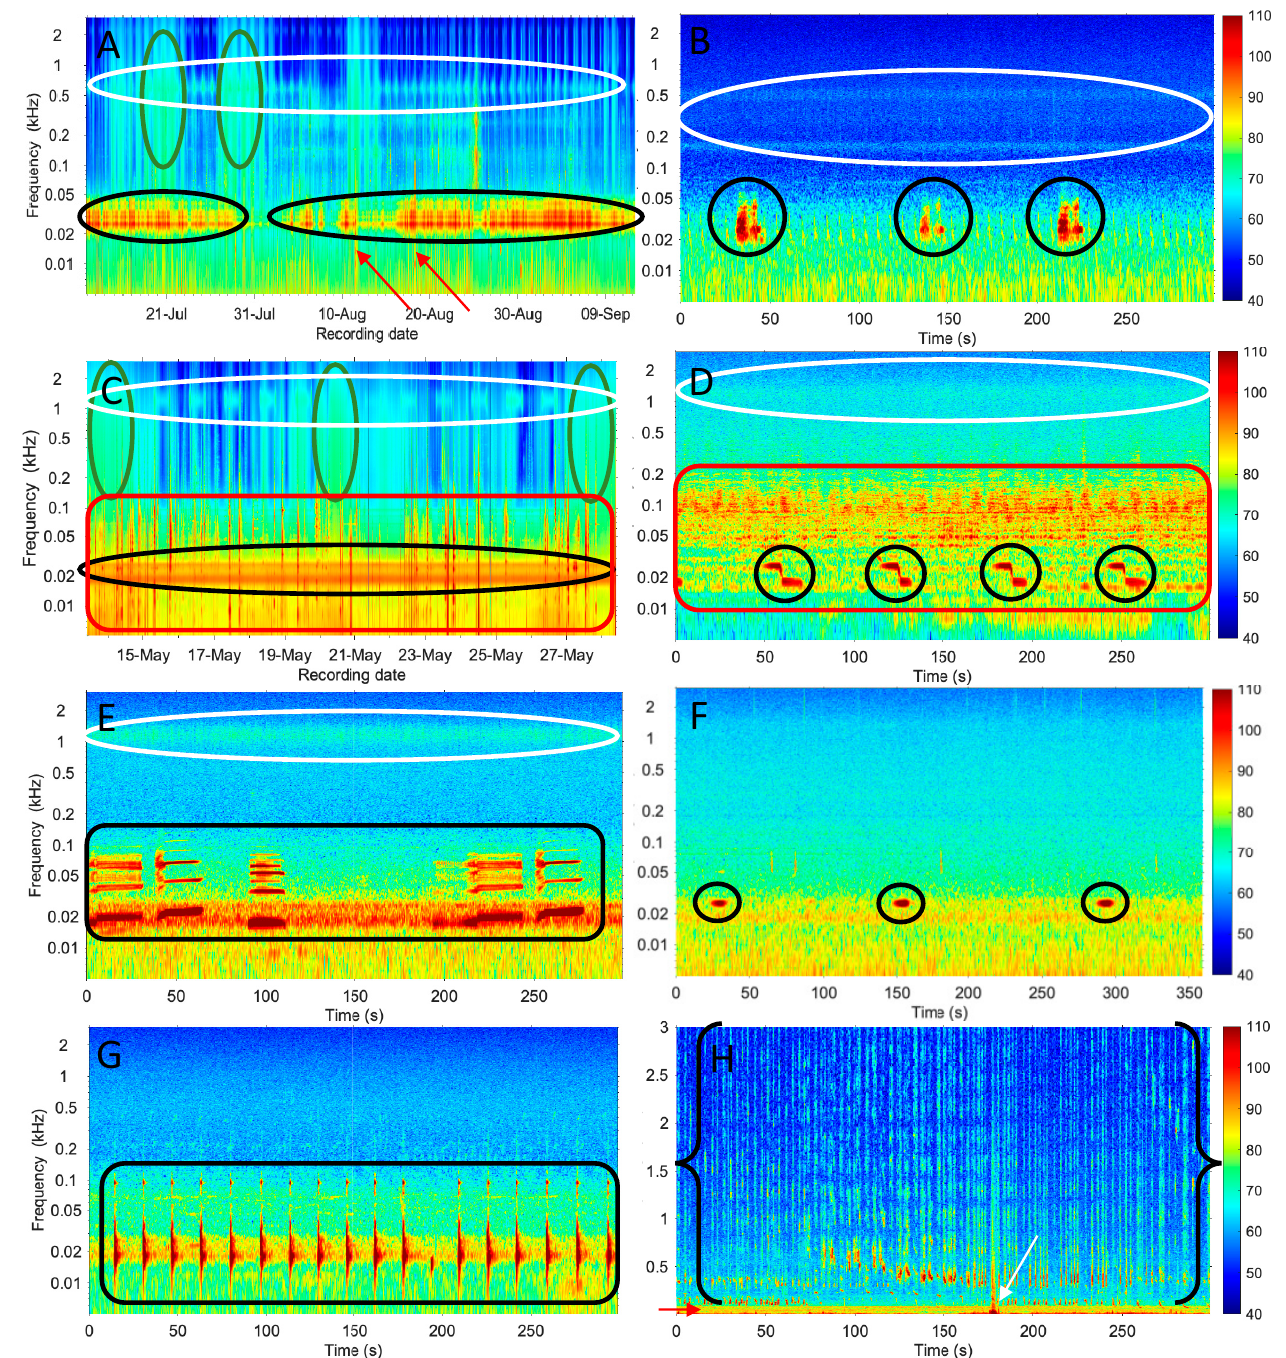
Figure 9. LTSAs and spectrograms [dB re 1 µPa 2 /Hz] showing ( A ) an Omura’s whale chorus and evening fish chorus at site 1; ( B ) Three Omura’s whale calls and a fish chorus at site 5 (this specific example is free from ships and wind); ( C ) An Antarctic blue whale chorus and evening fish chorus at site 22; ( D ) Four Antarctic blue whale Z-calls and a fish chorus at site 23; ( E ) Pygmy blue whale song in front of the Antarctic blue whale chorus and a fish chorus at site 24; ( F ) Three spot calls at site 19; ( G ) Fin whale song at site 14; and ( H ) Humpback whale song at site 6. Note the changing x- and y-scales. All panels but H use a logarithmic y-scale. H uses a linear y-scale to stress the great bandwidth of humpback whale song (100 Hz–>3 kHz) in comparison to the narrow bandwidth of ship noise in this example (<100 Hz), resulting in humpback whales dominating the C-SEL after integration over frequency. An animal (fish?) biting on the hydrophone is marked by the white arrow. Sound from whales, fish, ships, and wind are marked in black, white, red, and green, respectively.